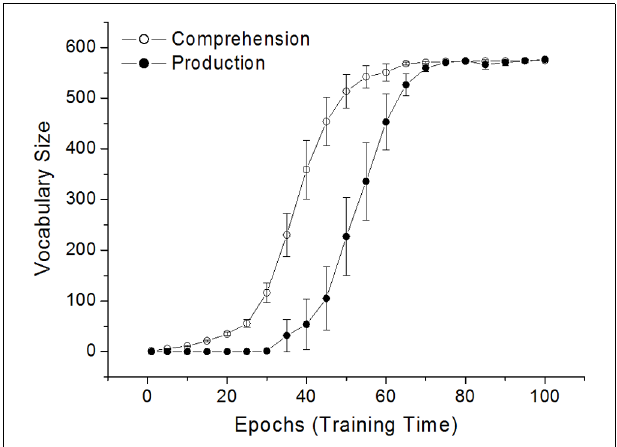
FIGURE 3 |Vocabulary spurt in the learning of the 591 CDI words by DevLex-II. Results are averaged across 10 simulation trials. Error bars indicate standard error of the mean (figure adapted from Li etal., 2007, reproduced with permission fromWiley and Sons,